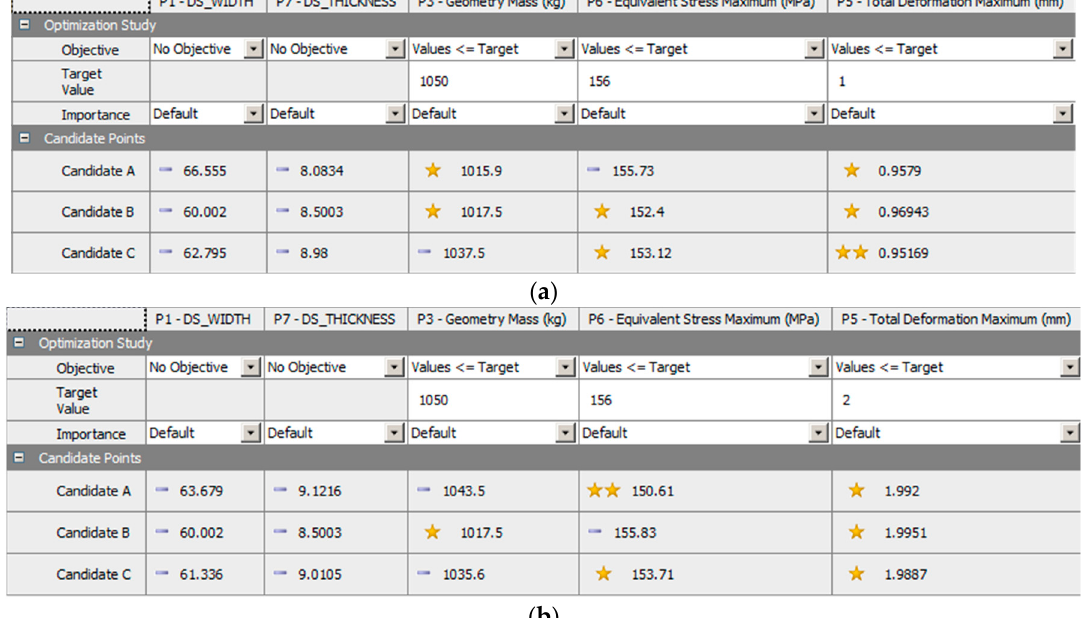
Figure 17. Optimal results for three sets of parameters at each working condition. ( a ) Bending conditions; ( b ) Torsional working conditions.The gray short line in the figure indicates that the optimization result is average, while the star mark indicates that the optimization effect is good. The more stars, the better the optimization result.